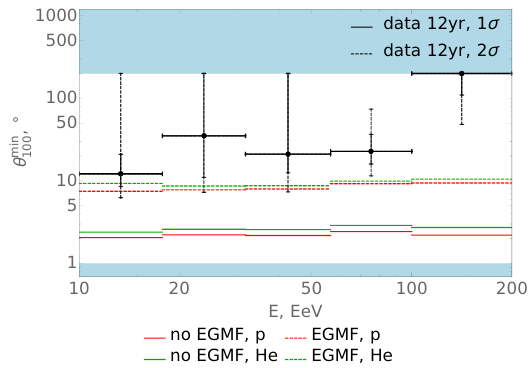
Figure 5. Comparison of the model predictions in the case of pure light composition (p, He) with the data, with zero and with maximum EGMF.